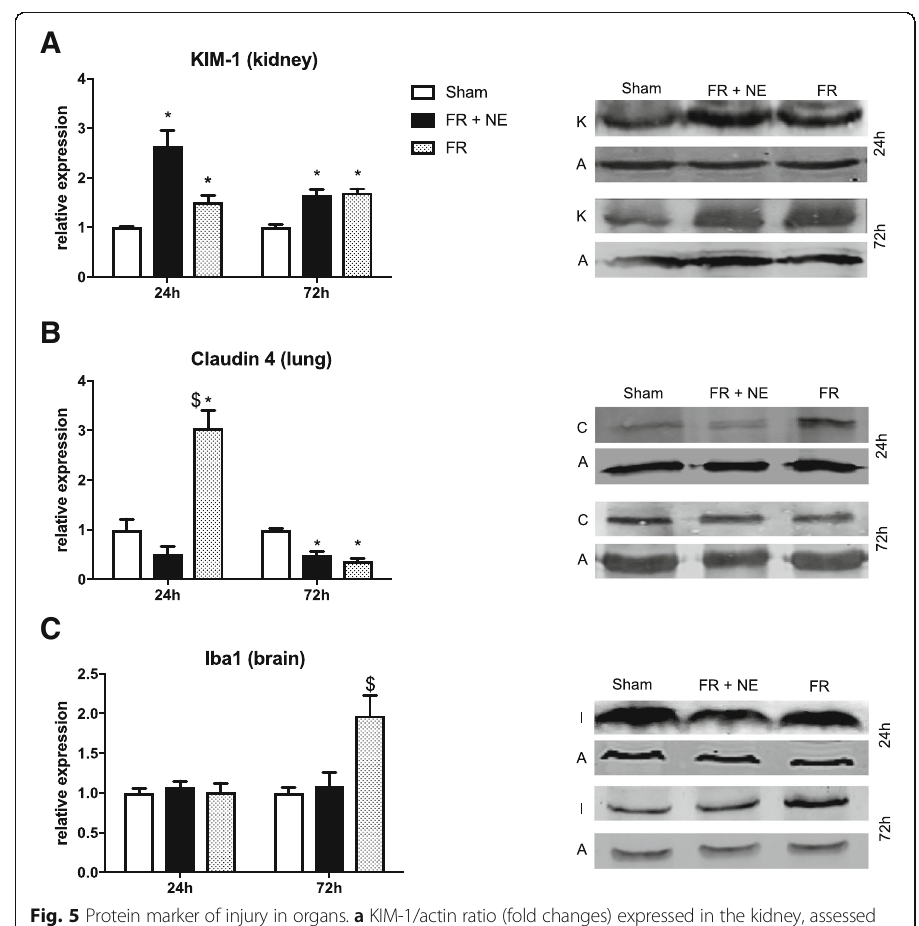
Fig. 5 Protein marker of injury in organs. a KIM-1/actin ratio (fold changes) expressed in the kidney, assessed by Western blotting in vitro after 24 h and 72 h of reperfusion. b Claudin-4/actin ratio expressed in the lung. c Iba1/actin ratio expressed in the amygdala of the brain. N =5 and dollar sign indicates significant difference between FR and FR+NE vs sham groups ( p <0.05). Side panels are representative Western blots; K: KIM-1, C: Claudin-4, I: Iba1, A: